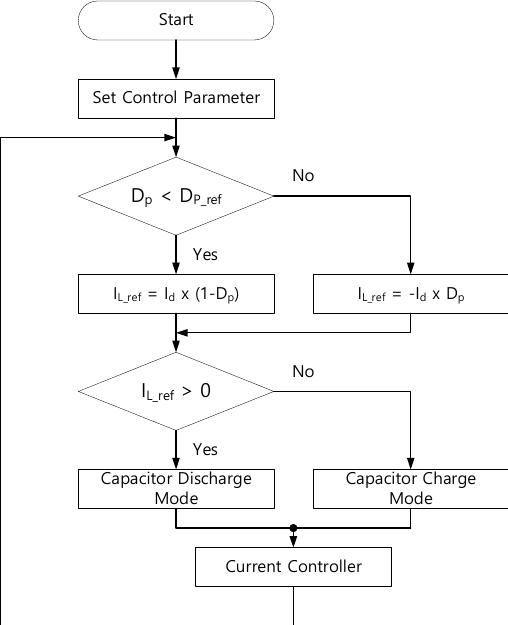
Figure 8. Control block diagram of the pulse charger.